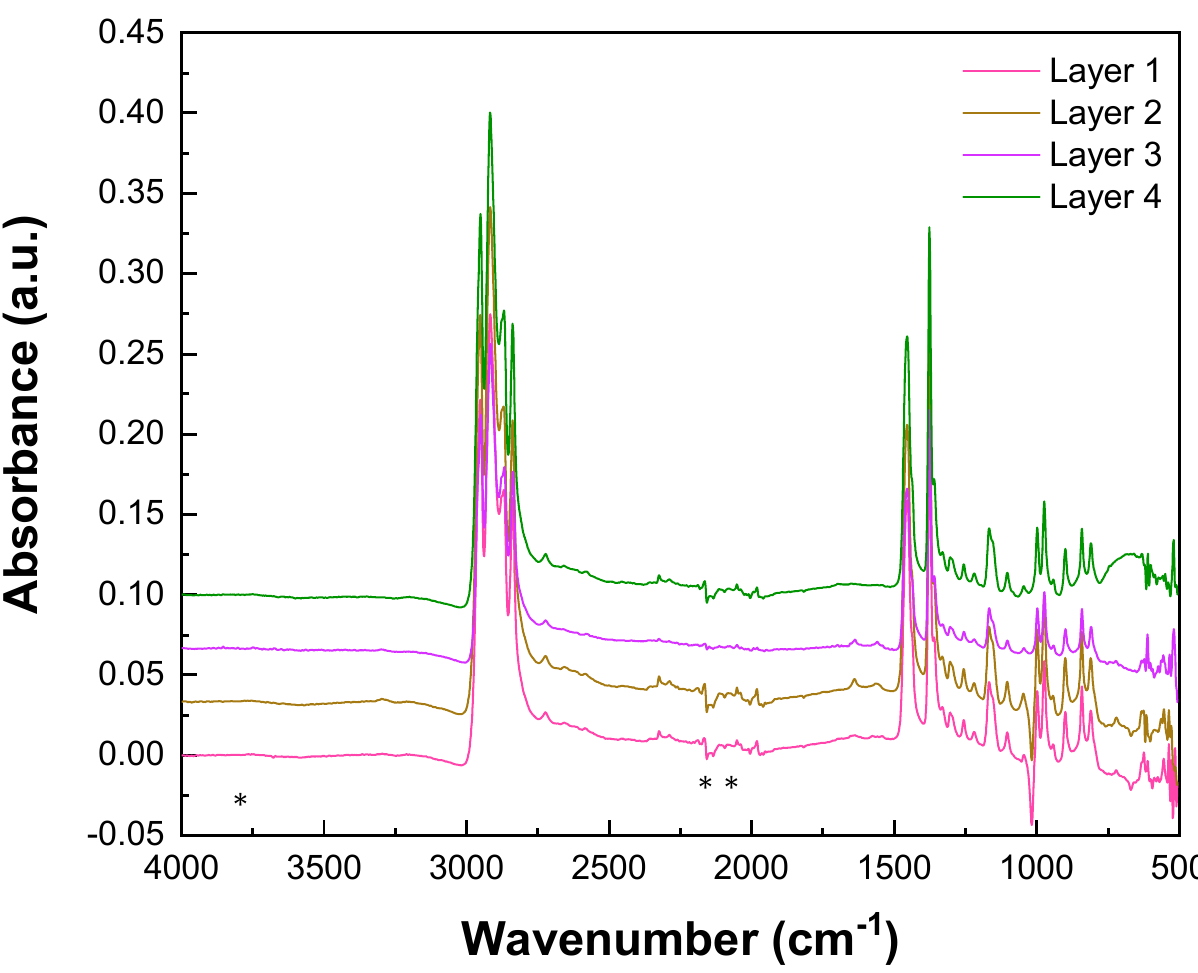
Figure 2. Infrared spectra of the four layers of the Valmy FFP2 mask. Stars are pointing bands that do not belong to the PP characteristic infrared spectrum. Stars correspond to bands observed only on layers 2 and 3 (for attribution, see Table 2). Table 2. Attribution of the additional bands observed in the infrared spectra of layers 2 and 3 of the